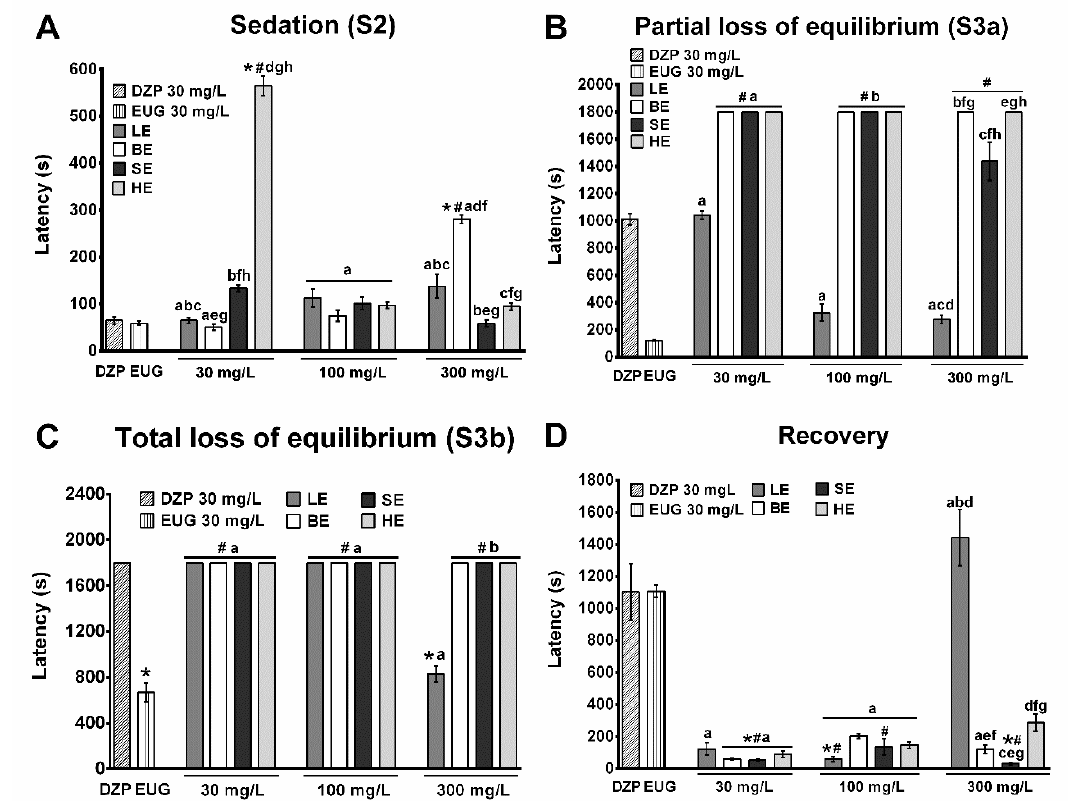
Figure 1. M. tinctoria crude extracts induce sedation in silver catfish. Sedation levels are described as S2: light sedation; S3a: sedation with partial loss of equilibrium; S3b: sedation with total loss of equilibrium; Recovery: time spend for total sedation recovery, where the animal shows normal behavior similar to those in water control. The abscissa shows the concentrations of the tested samples (in mg/L), while the ordinate represents the latency time (in seconds) until the effect was observed. Different lowercase letters indicate significant differences between samples: Leaves (LE), bark (BE), sapwood (SE), and heartwood extracts (HE) at each evaluated concentration ( p < 0.05). * p < 0.05 = statistical difference from diazepam (DZP); # p < 0.05 = statistical difference from eugenol (EUG). Kruskal–Wallis test followed by Dunn’s test. ( A ) Stage S2—Sedation; ( B ) Stage S3a—Partial loss of equilibrium; ( C ) Stage 3b—Total loss of equilibrium; ( D ) Recovery.